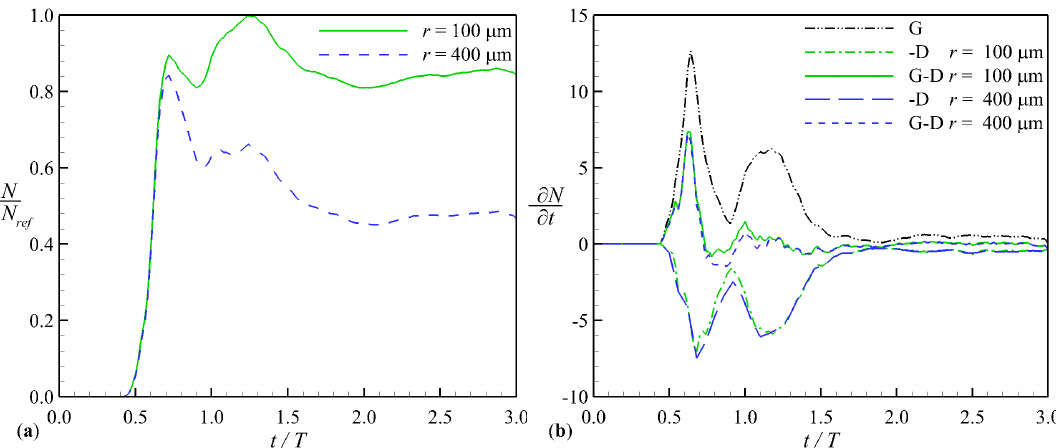
Figure 4. Time histories of ( a ) the number of droplets N / N ref , and ( b ) generation rate GT / N ref and disappearance rate − DT / N ref of droplets in Case